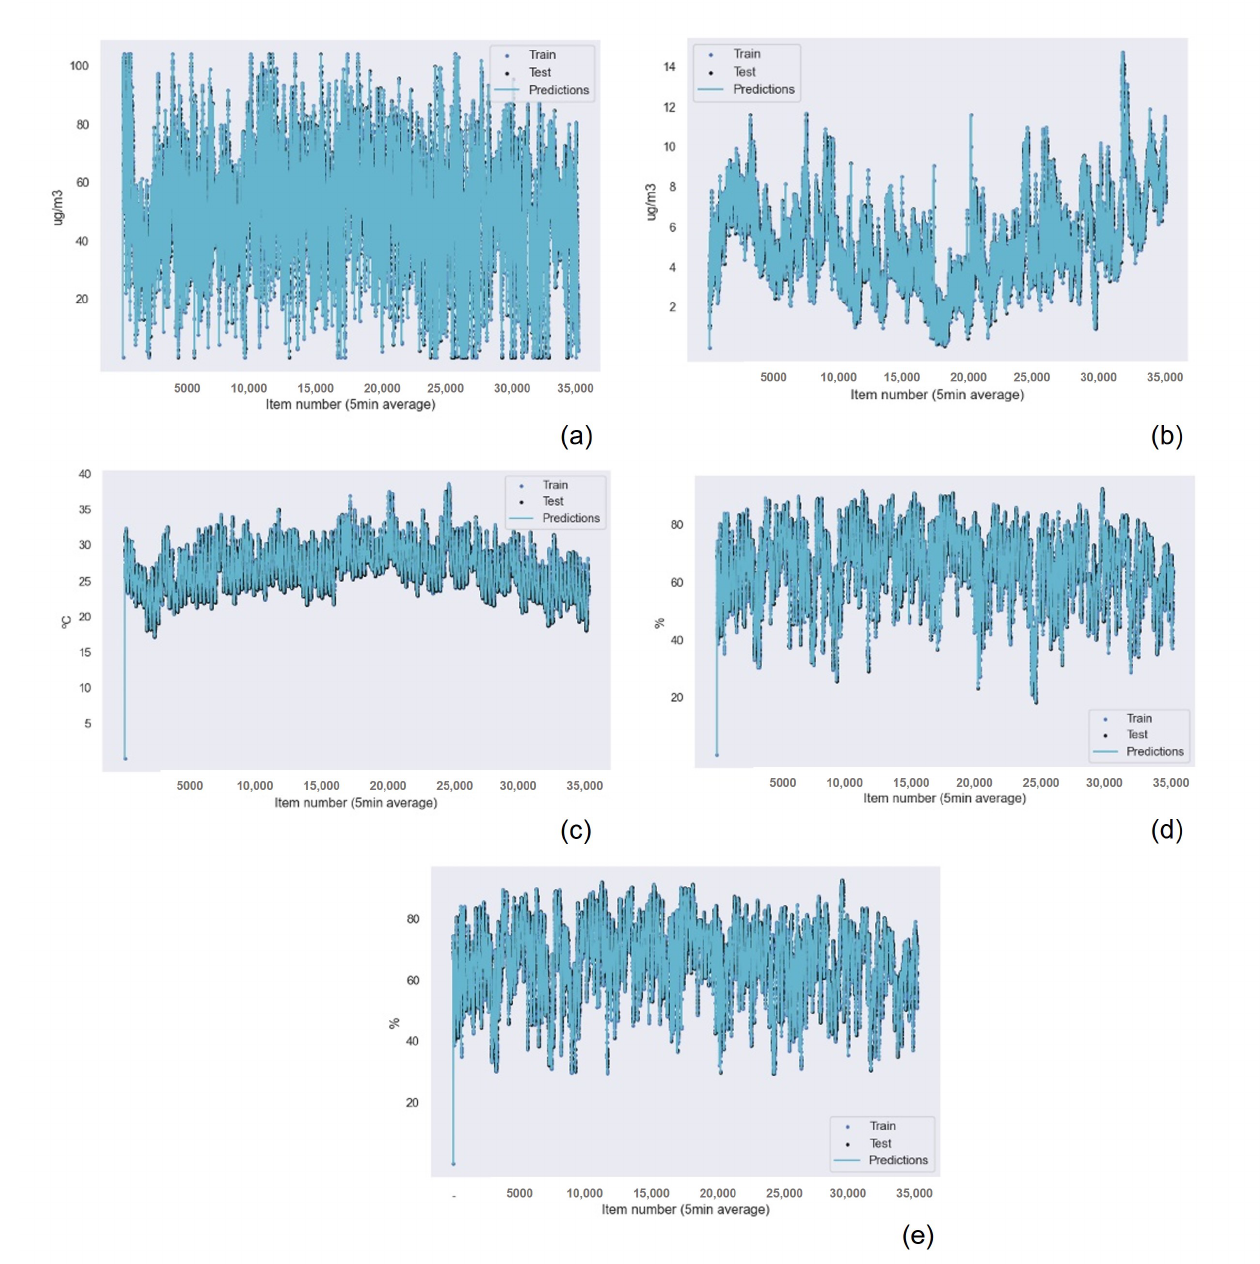
Figure 14. Gaussian Process Regression graphical results for the polluting gas measuring device of ( a ) the O 3 data without outliers, ( b ) the SO 2 data, ( c ) the temperature data, ( d ) the humidity data with outliers, and ( e ) the humidity data without